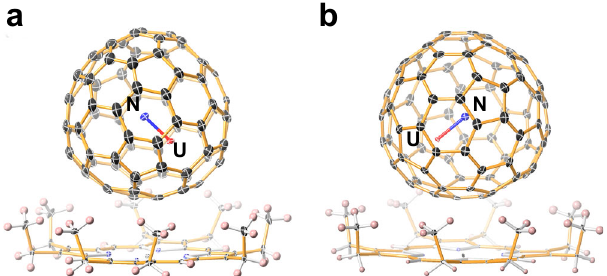
Fig.1|ORTEPdrawingofUN@ C 2 (5)-C 82 ·[Ni II (OEP)]andUN@ C s (6)-C 82 ·[Ni II (OEP)] with 20% thermal ellipsoids. a UN@ C 2 (5)-C 82 ·[Ni II (OEP)]. b UN@ C s (6)- C 82 ·[Ni II (OEP)].OnlythemajorUsiteisshown.Forclarity,thesolventmoleculesand minor metal sites are